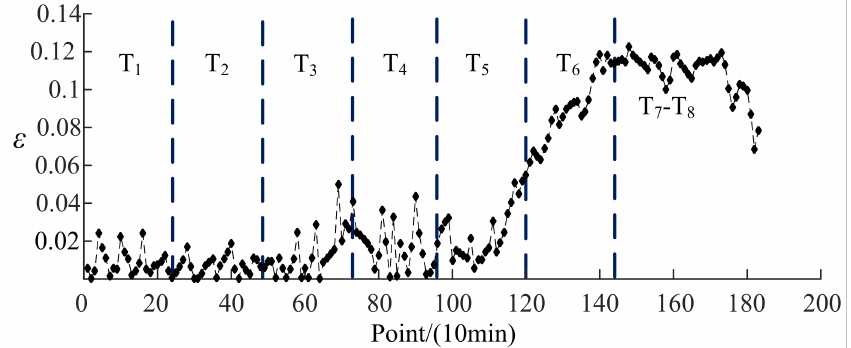
Figure 10. Relative error of Gearbox bearing